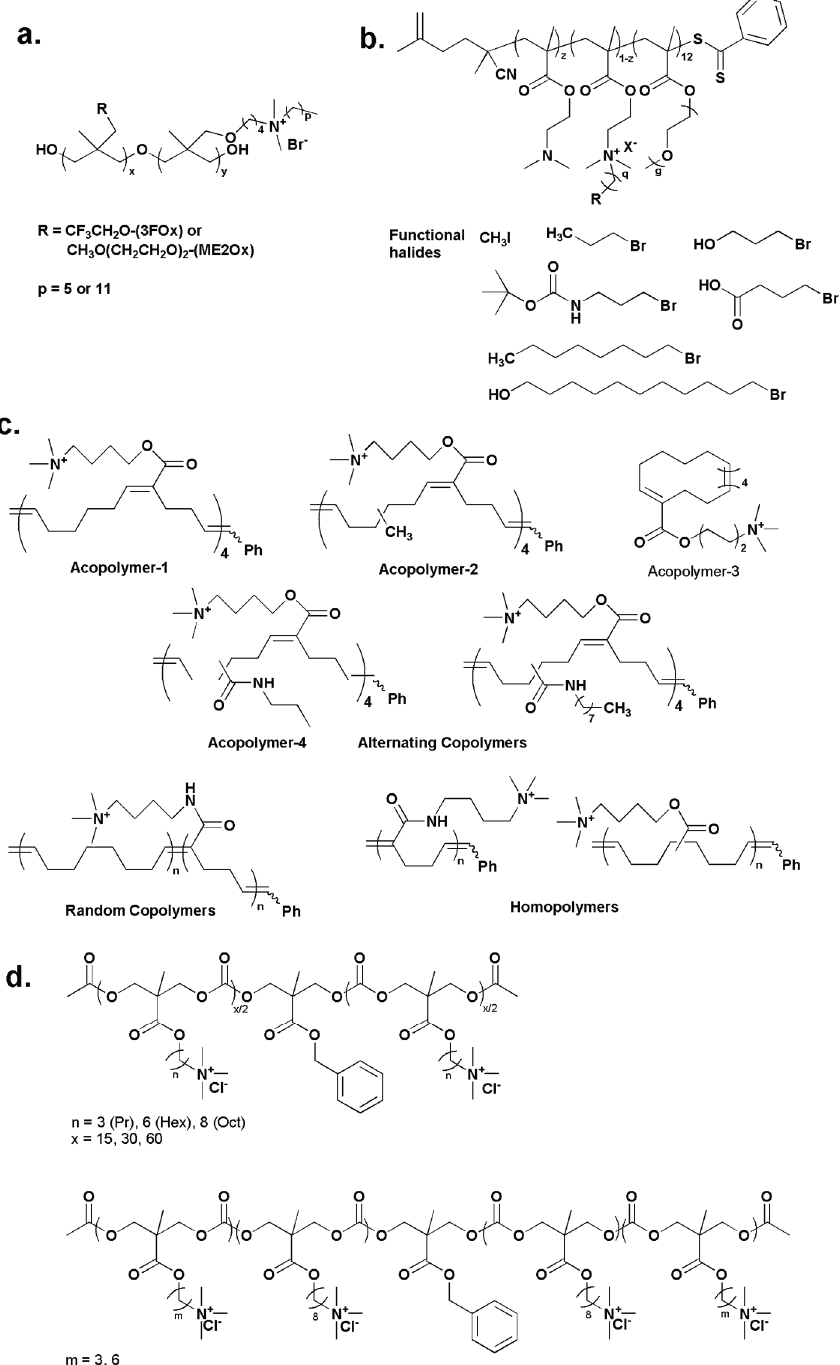
Figure 7. ( a ) Random copolymeric oxetane with QAS and either trifluoroethoxy or PEGlyted side chains, adapted with permission from [170]. ( b ) Well-defined pegylated-polymers with different amphiphilic balance and chemical functionalities, adapted with permission from [171]; ( c ) Synthetic antimicrobial peptides with alternating, random and uniform backbones, adapted with permission from [172]. ( d ) Antimicrobial polycarbonates with different amphiphilic balance, adapted with permission from